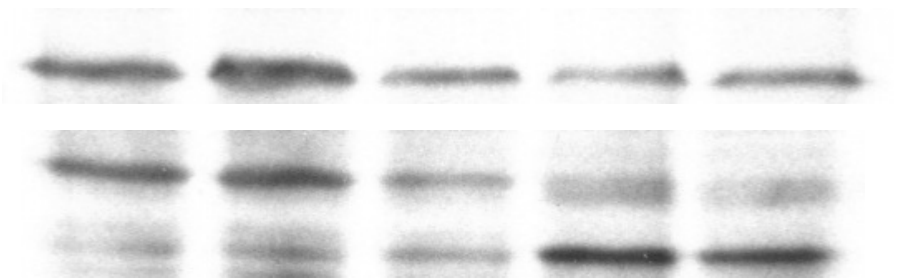
Figure 5. The effects of MPA on caspase-3 activation in MCF-7 cells. Cleaved caspase-3 and β -actin were detected by Western blot. MCF-7 cells were treated with 50 or 100  M of MPA for 12 or 24 h. ( a ) From the left side: Lane 1, control; lane 2, MPA 50  M for 12 h; lane 3, MPA 100  M for 12 h; lane 4, MPA 50  M for 24 h; lane 5, MPA 100  M for 24 h. ( b ) Quantification of cleaved caspase-3 presented